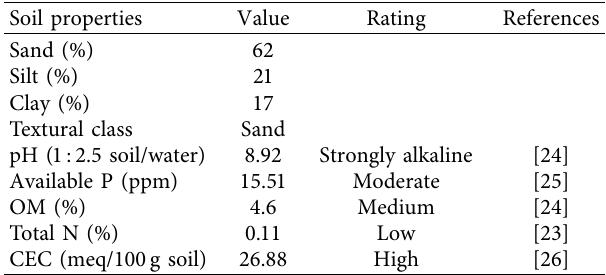
Table 3: Soil physical and chemical properties of the experimental site.